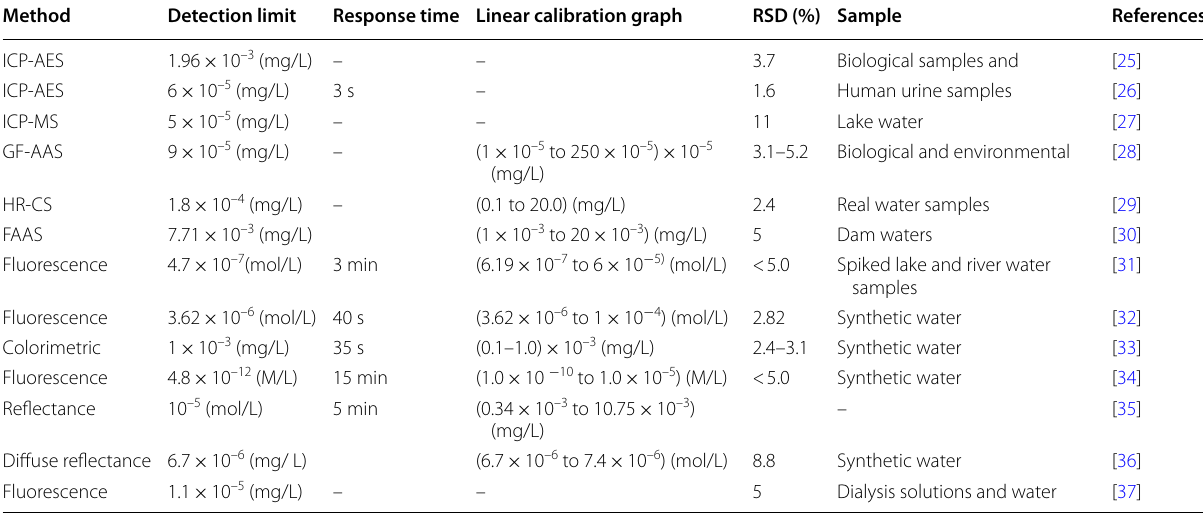
Table 1 Comparison of the analytical methods for the determination of aluminium ion